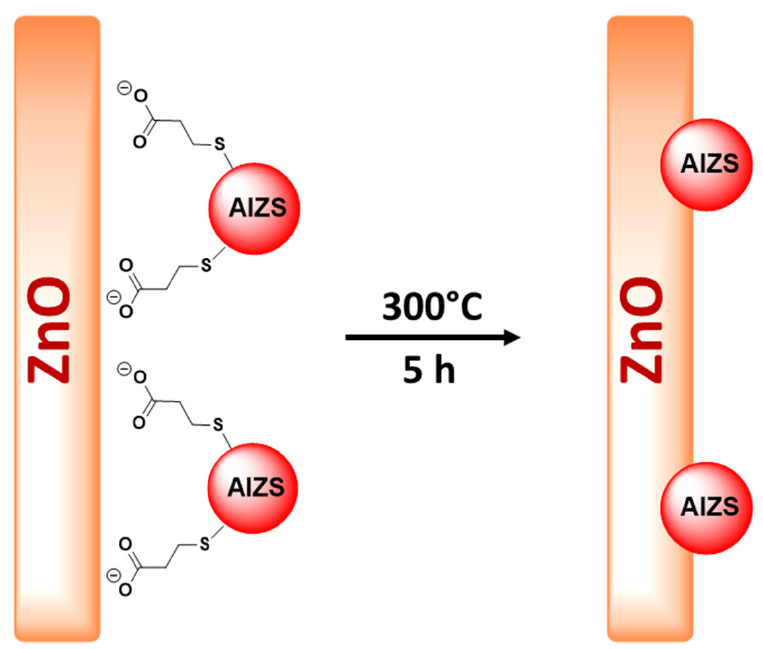
Scheme 1. Schematic representation of ZnO/AIZS photocatalysts’ synthesis.